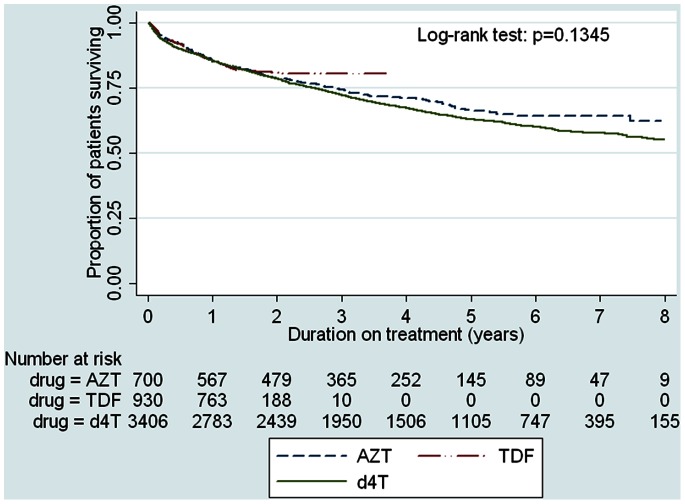
Kaplan-Meier estimates of time to programme losses (loss to follow-up/death) in adults initiated on ART.